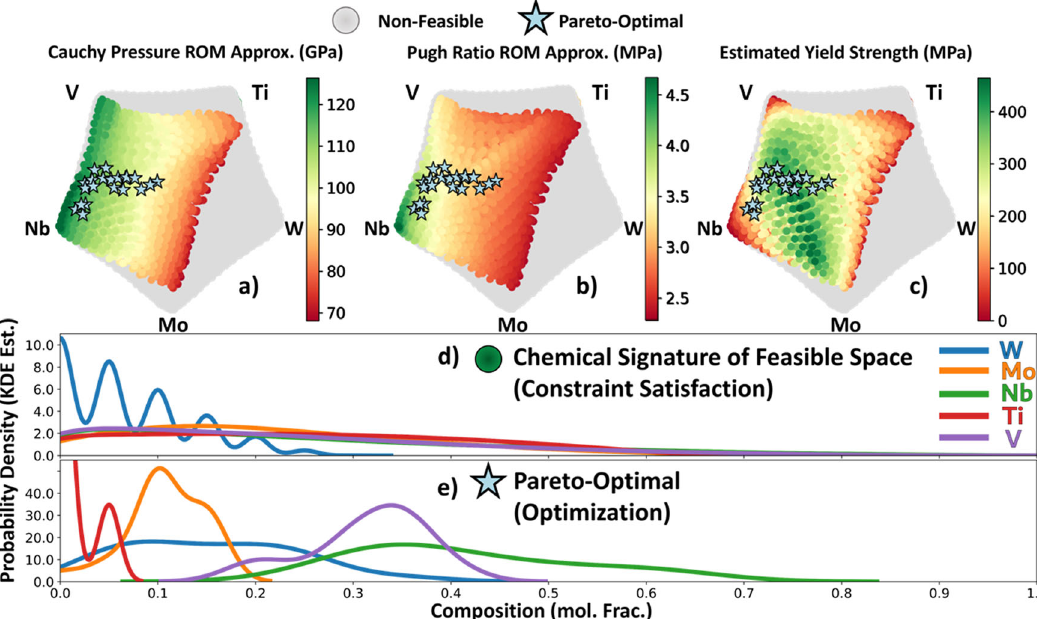
Fig. 4 Visualizations of constraint-passing and pareto-optimal alloys. a ROM Cauchy Pressure (indicator of true objective) plotted over the design space. b ROM Pugh Ratio (indicator of true objective) objective plotted over the design space. c Estimated yield strength from the Curtin – Maresca model plotted over the design space. d Chemical signature of the feasible chemical space. e Chemical signature of Pareto- optimal set of Table 2. We recommend further investigation of these 21 Pareto- optimal alloys to properly characterize their behavior in the context of GTE blade applications.